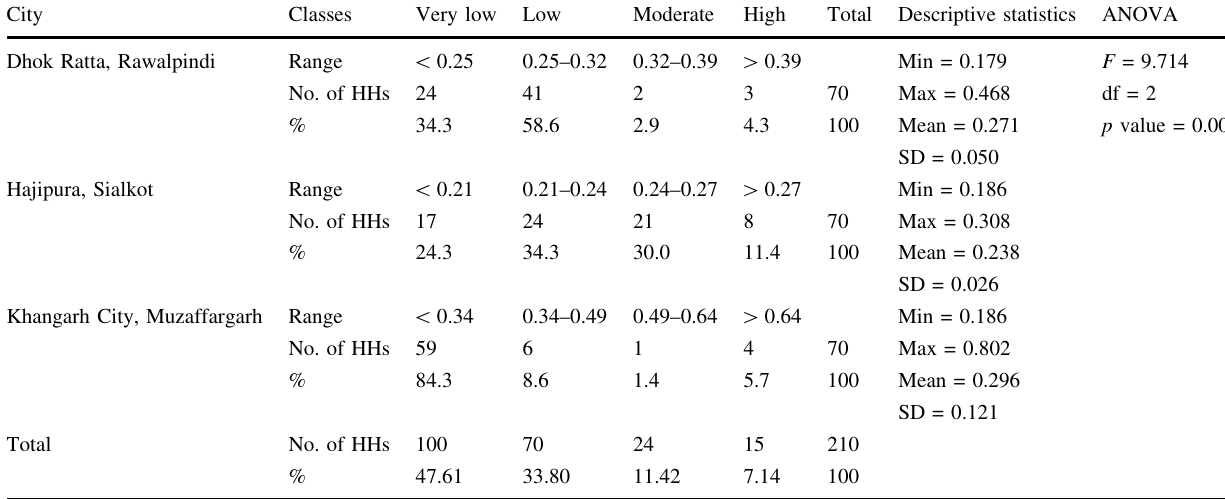
Table 4 Physical and infrastructural vulnerability to urban flooding in Dhok Ratta, Hajipura, and Khangarh City, Punjab Province, Pakistan (HHs = Households; n = 210) City